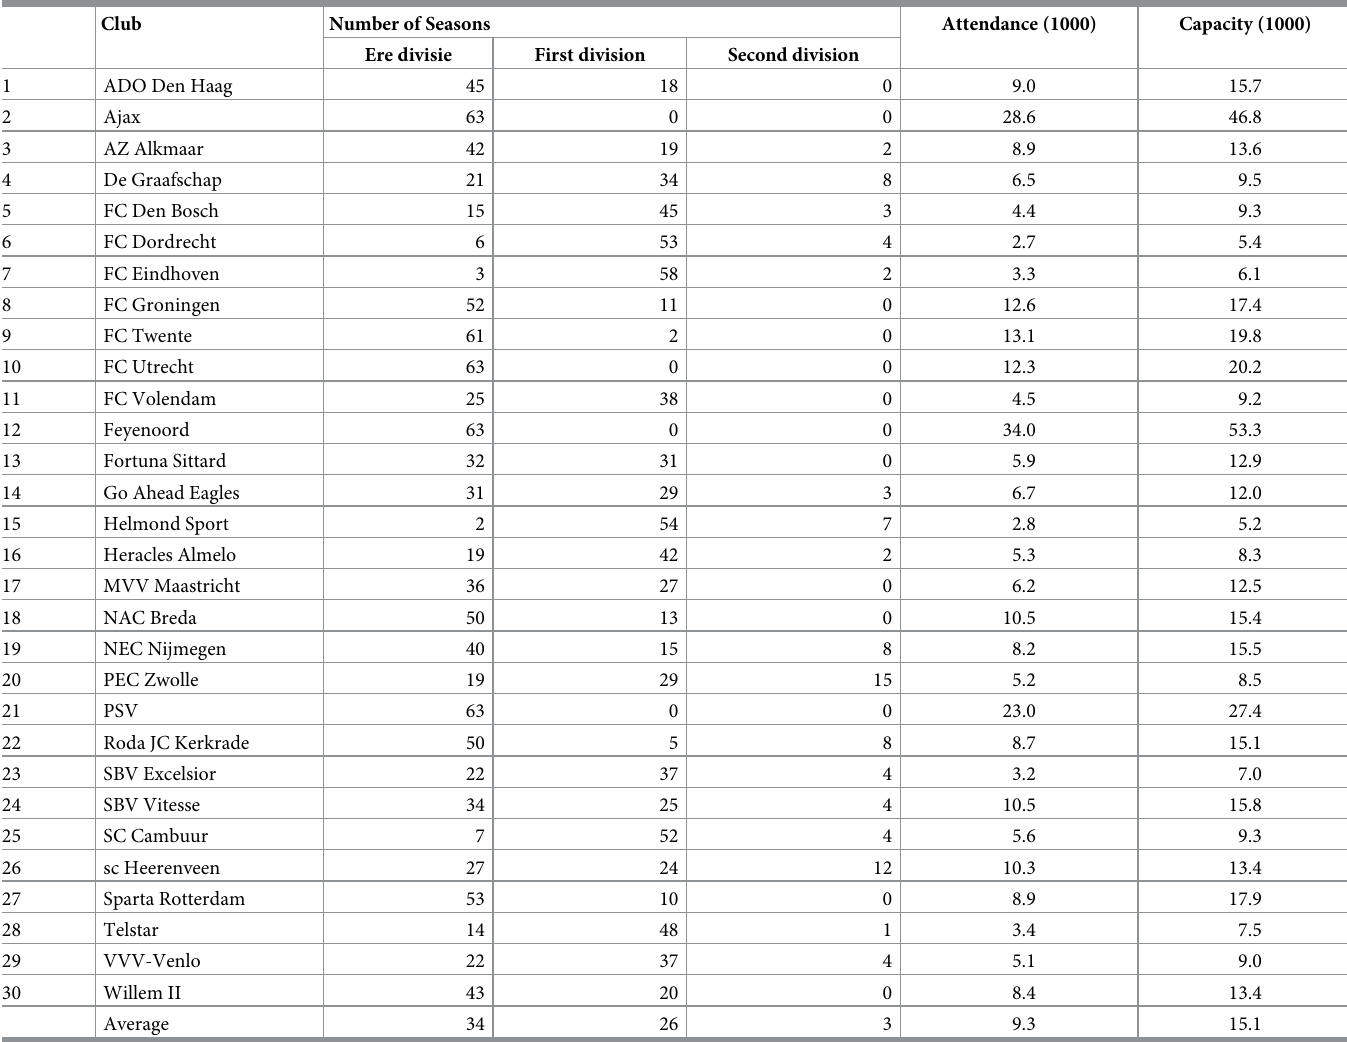
Table 2. Summary statistics by club;